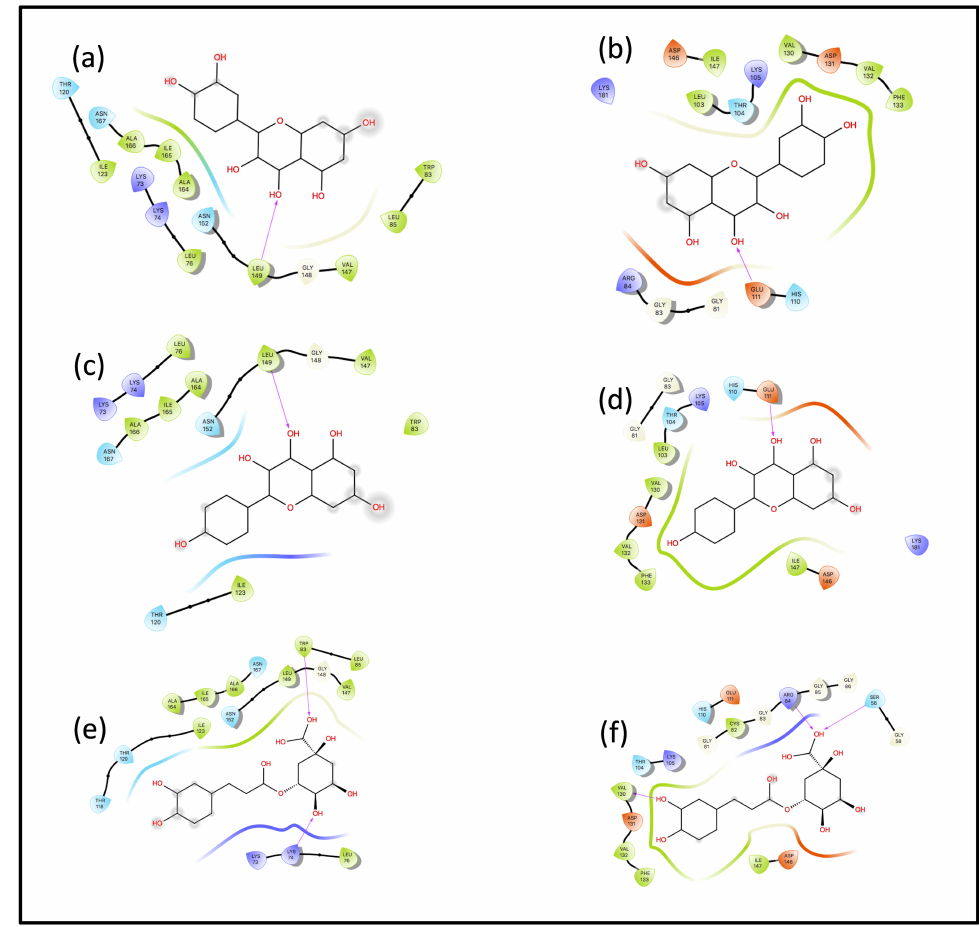
Figure 5. Ligand interaction diagrams for NS3 and NS5 receptors from Schrödinger and Maestro. ( a ) Quercetin + NS3, ( b ) Quercetin + NS5, ( c ) Kaempferol + NS3, ( d ) Kaempferol + NS5, ( e ) Chloro- genic acid + NS3, and ( f ) Chlorogenic acid + NS5. Color codes for residues by orange = charged (negative), purple = charged (positive), white = Glycine, green = hydrophobic, light blue = polar, purple arrow = hydrogen